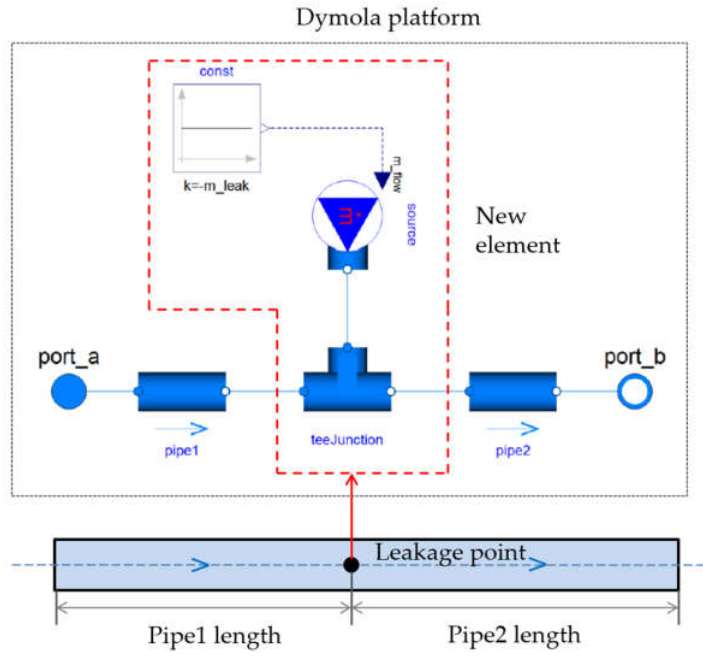
Figure 4. Hydraulic model of pipe leakage on the Dymola